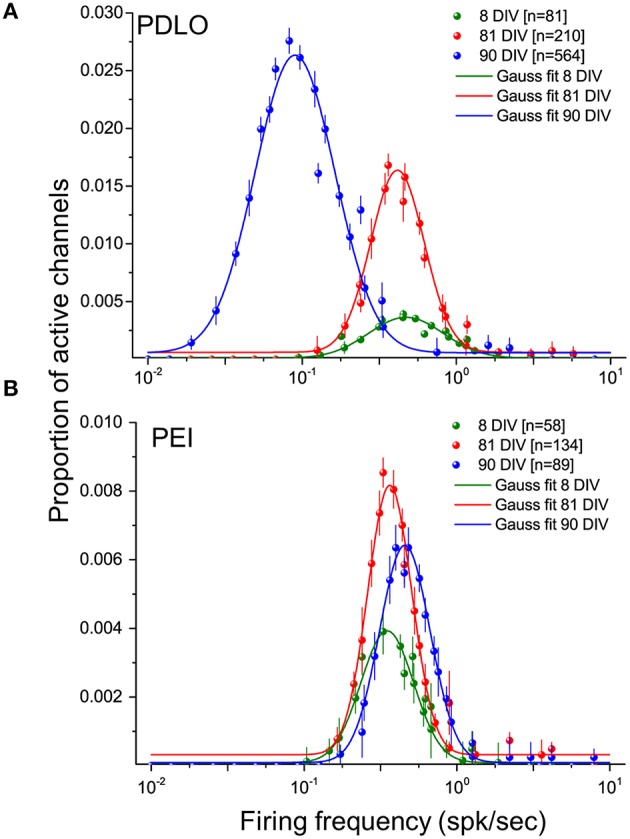
Distributions of the firing frequencies of iCell neuronal networks is lognormal- like and allow to elucidate the dynamic behavior of human iCell neuronal networks during development.(A) Gaussian fits of the firing frequency distributions for three developmental phases of neurons grown on PDLO coated substrates, i.e., at 8, 81, 90 DIV. The means of the distributions at 8 and 81 DIV hold the same frequency position, but a higher peak of the distribution (red) is observed at 81 DIV. At 90 DIV, the mean of the distribution (blue) shifts left toward low-firing rates and the occurrence of active electrodes reaches its peak at this range of low frequency. (B) Neuronal cultures grown on PEI coated substrates hold over development the means of their lognormal-like distributions at the same frequency range (no shift). The peak of these distributions indicates a lower probability of active electrode occurrence during development compared with networks frown on PDLO coated substrates.